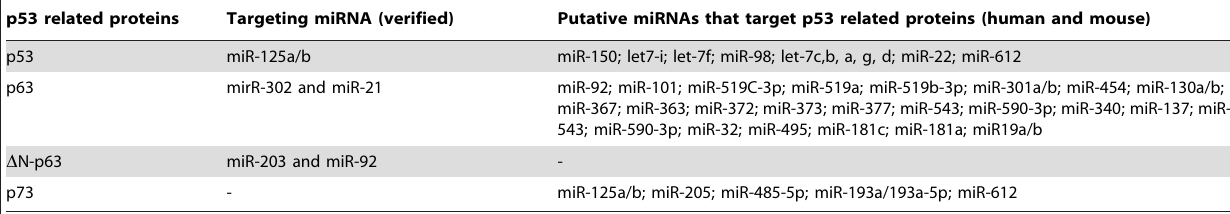
p53 related proteins